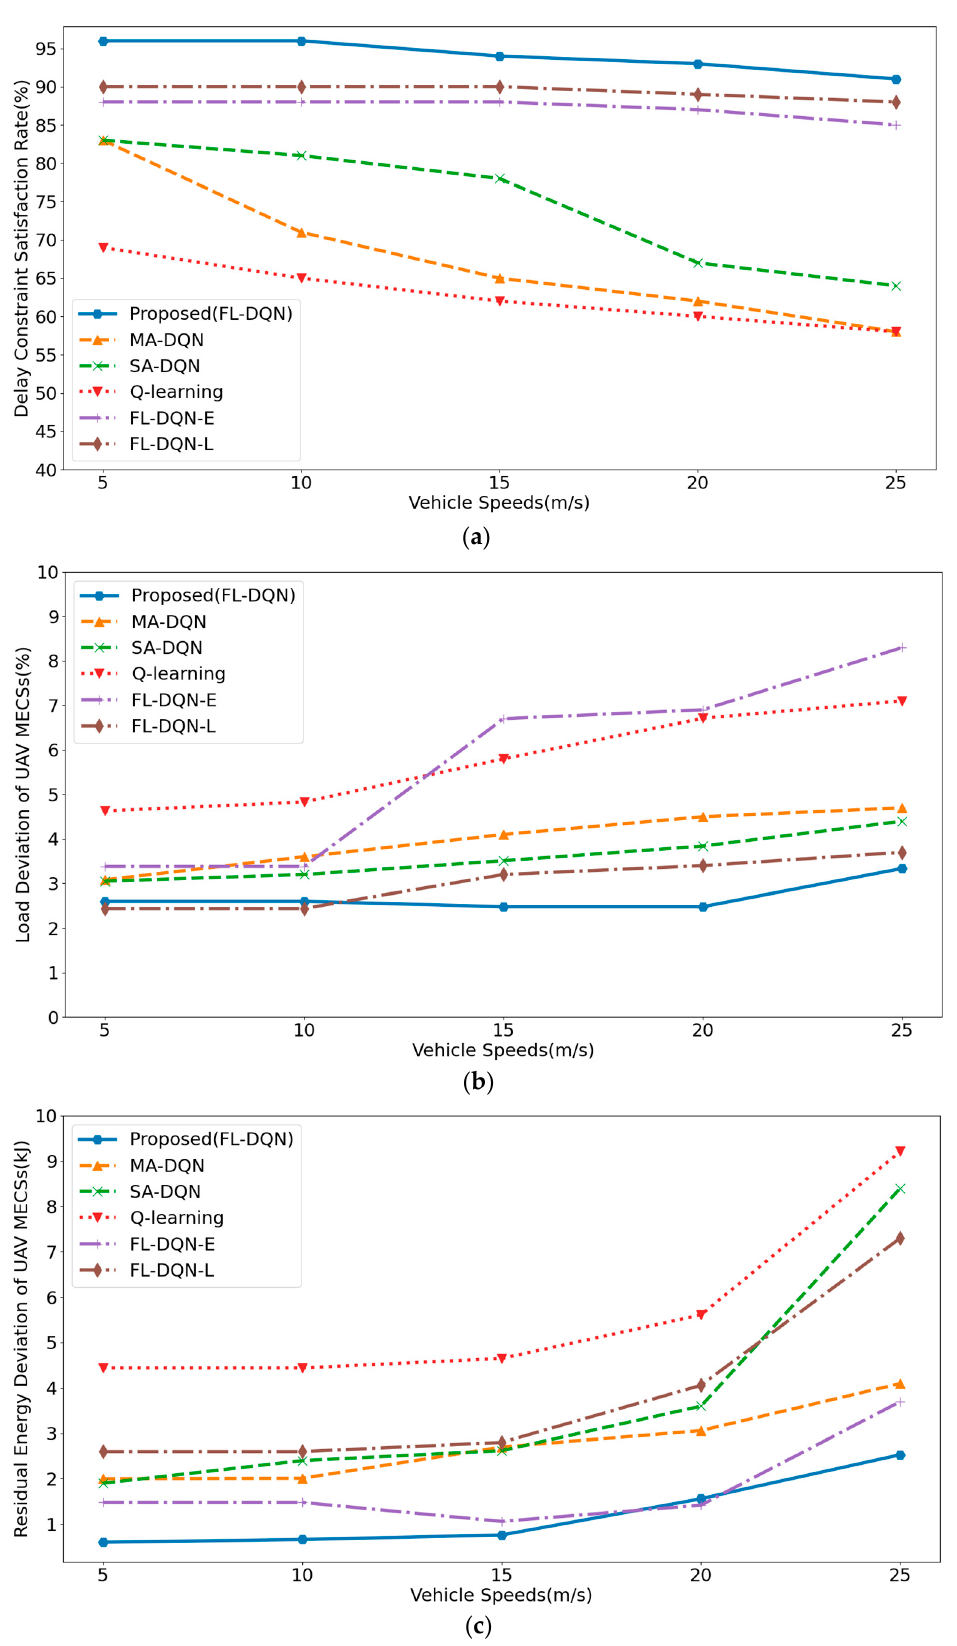
Figure 8. Experimental results with varying vehicle speeds: ( a ) delay constraint satisfaction rate; ( b ) load deviation of UAV MECSs; ( c ) residual energy deviation of UAV MECSs.